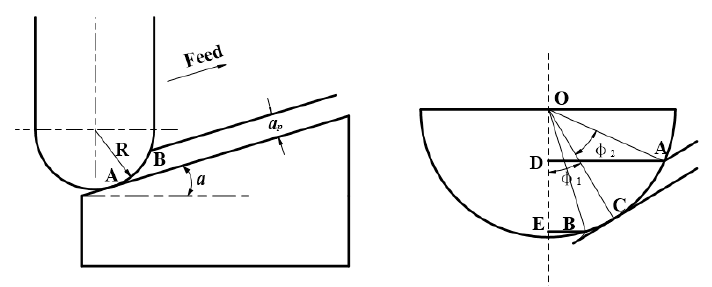
Figure 11. Effective cutting radius when milling an inclined plane [20]. Figure 11. E ff ective cutting radius when milling an inclined plane [20].